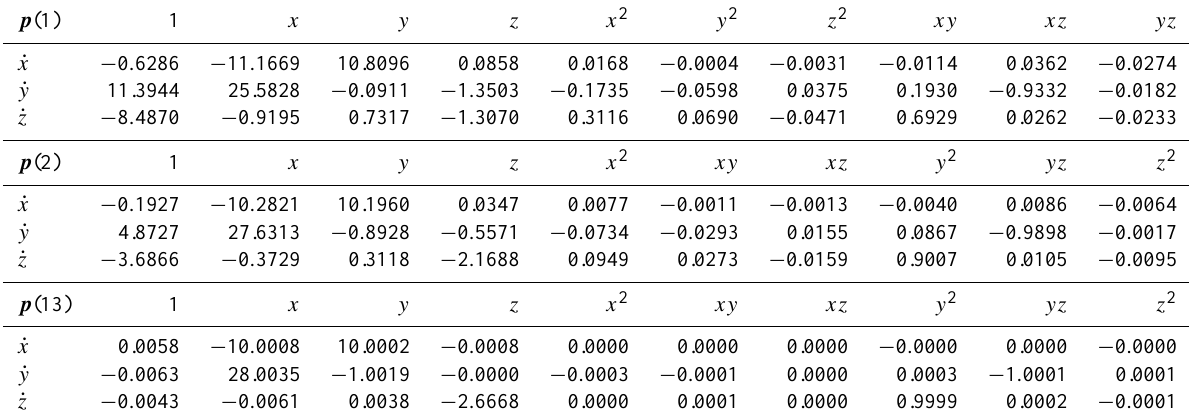
Table 1. Estimated coefficients in the quadratic form (4) for the 1st, 2nd and last iteration of the